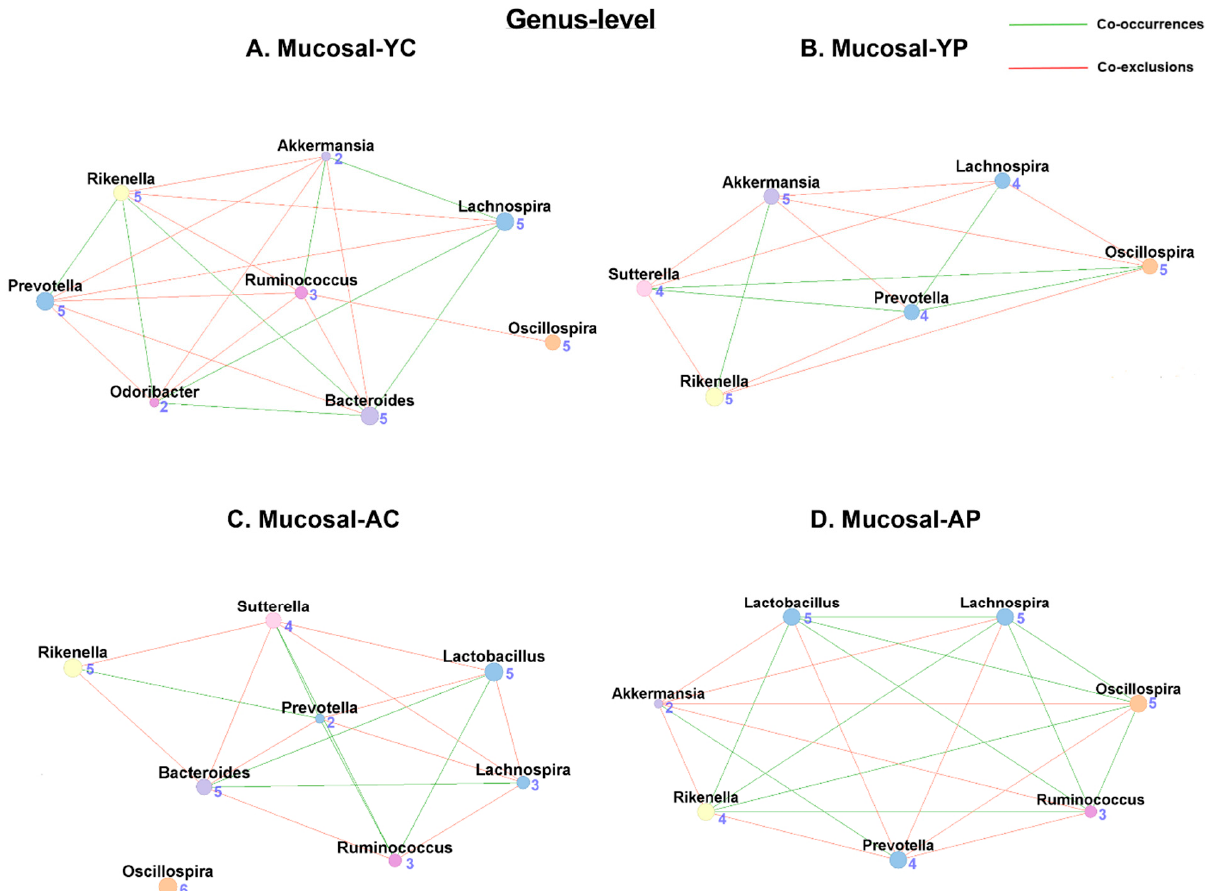
Figure 8. Microbial co-occurrence in the mucosal microbiome in young and aging mice at the genus level. Co-occurrence networks were constructed on the basis of the relative abundance profiles of fecal microbes using Kendall’s Tau correlation analysis in young control ( A ), young probiotic ( B ), aging control ( C ), and aging probiotic ( D ) groups. Each node represents a phylum. Each edge indicates the sign of the association (green = positive (co-occurrences), red = negative (co-exclusions)). The thickness of the nodes represents the level of association between taxa.